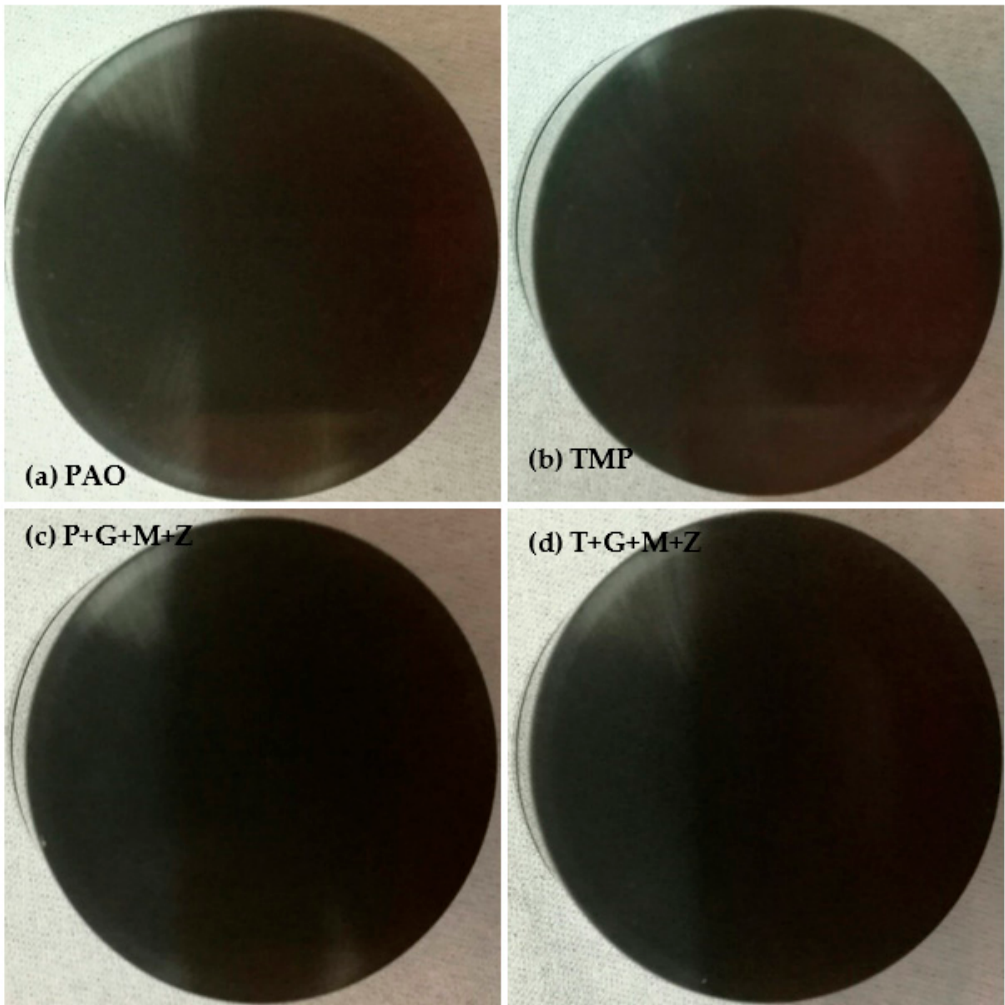
Figure 8. Optical images of a-C:H-coated tappets after cylinder head testing in combination with a-C:H-coated camlobes under various conditions with TMP-based and PAO-based lubricants.